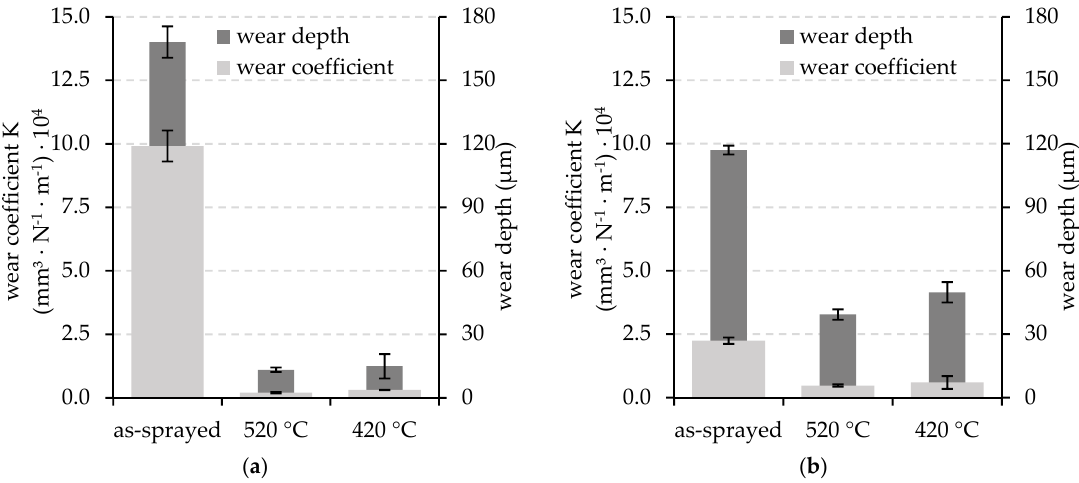
Figure 5. Wear values of the AISI 316L HVOF coating depending on the state of thermochemical treatment for different wear tests ( a ) ball-on-disk tests and ( b ) reciprocating ball-on-plane tests.